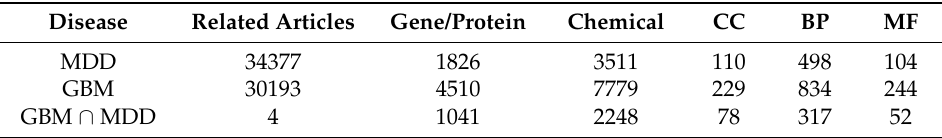
Table 1. The results of text-mining in COREMINE platform. MDD: Major Depressive Disorder; GBM: glioblastoma; Related articles: Pubmed search with a concept or expert name to generate a list of articles; BP: Biology Process; CC: Cellular Component; MF: Molecular Function. Disease Related Articles Gene/Protein Chemical CC BP MF MDD 34377 1826 3511 110 498 104 GBM 30193 4510